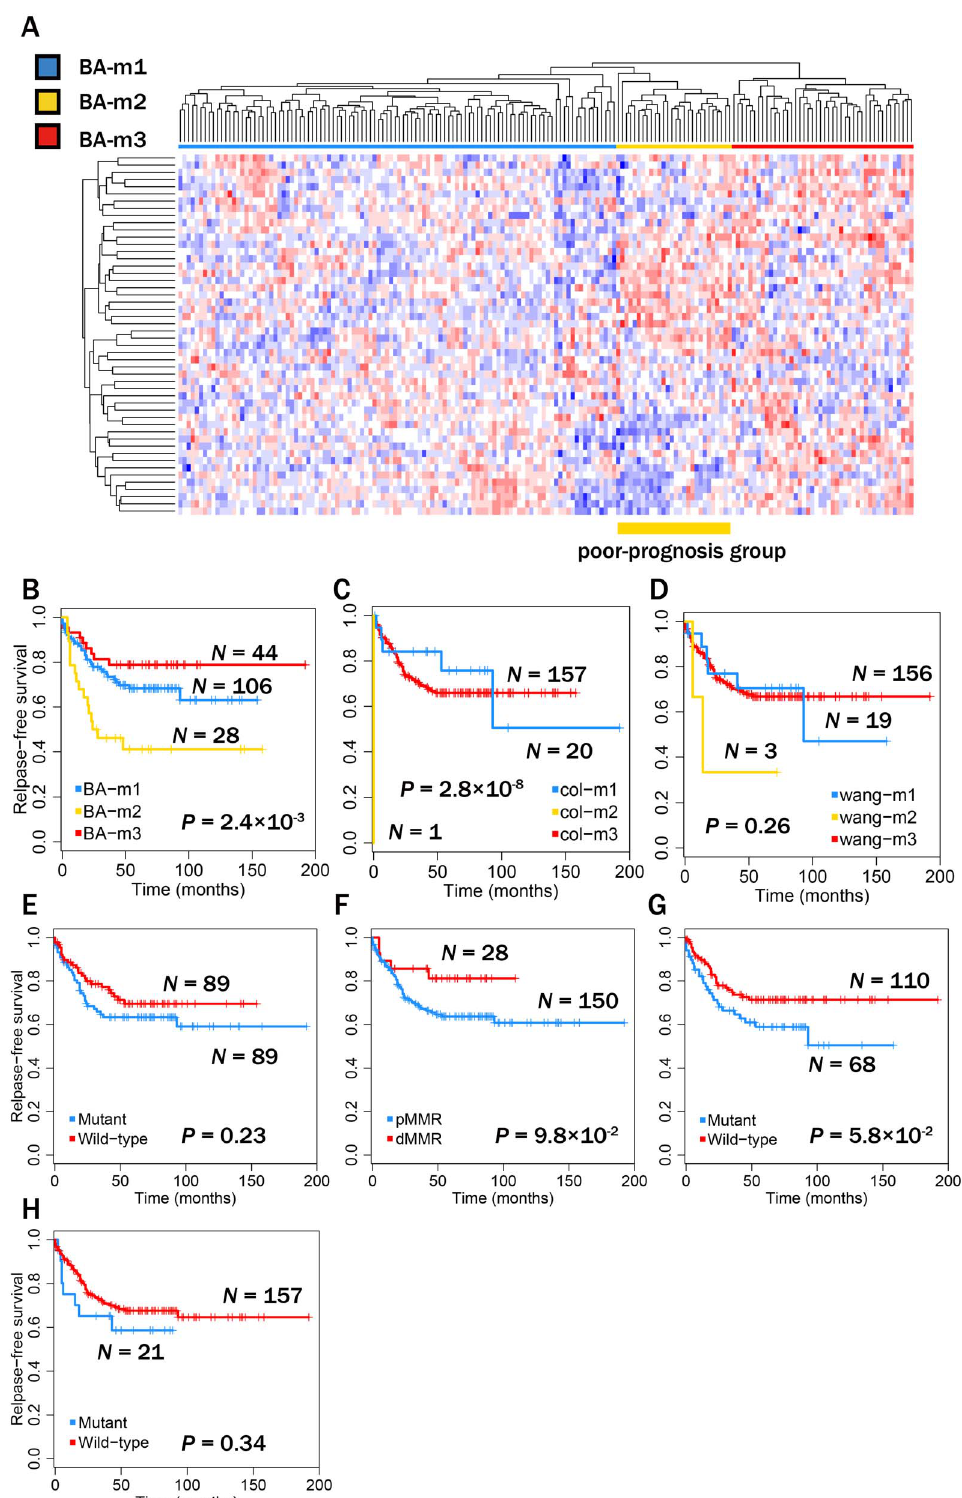
Figure 4. Identification of the prognostic ability of markers. Their prognostic ability was examined using a dataset of tissue samples from patients with CRC [26]. ( A ) Heatmap of CRC tumor samples with subgroups classified by the expression patterns of bridge proteins: BA-m1 (blue), BA- m2 (yellow) and BA-m3 (red). Prognostic ability was assessed by Kaplan-Meier survival analyses. The BA-m2 group showed the poorest prognosis. ( B ) Prognostic ability of our bridge proteins. ( C ) Prognostic ability of the ColoPrint gene set [28], with subgroups classified as col-m1 (blue), col-m2 (yellow) and col-m3 (red). ( D ) Prognostic ability of the Wang et al. signature gene set [27], with subgroups classified as wang-m1 (blue), wang-m2 (yellow) and wang-m3 (red). ( E ) Prognostic ability of p53 mutation status, mutant and wild-type. ( F ) Prognostic ability of mismatch repair gene (MMR)